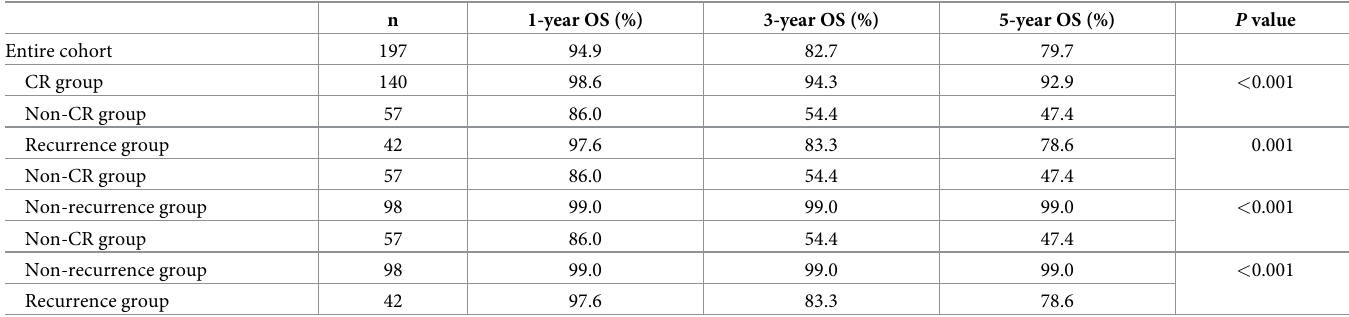
Table 1. Comparison of OS rates in each cohort of children with hepatoblastoma.